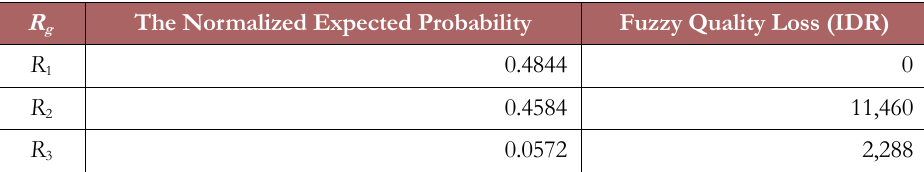
Table 3. Fuzzy quality loss for each quality